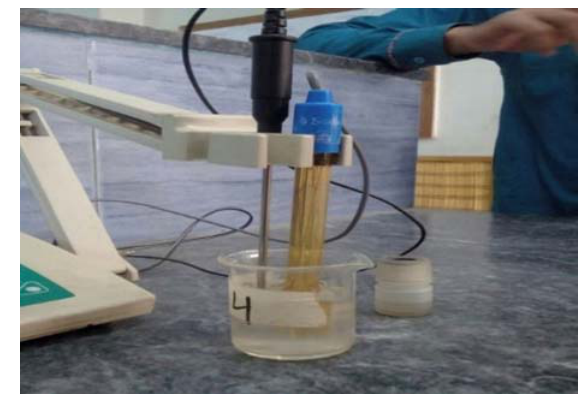
FIG. 1. MEASURING PH OF WASTEWATER (UOL LAB)